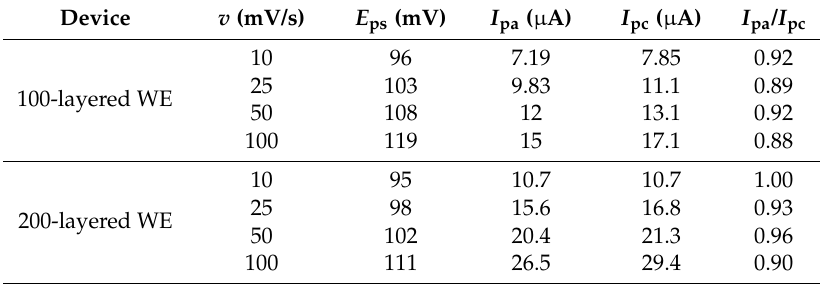
Table 2. Electrochemical data for 100- and 200-layered paper-based electroanalytical device by cyclic voltammetry at different sweeping